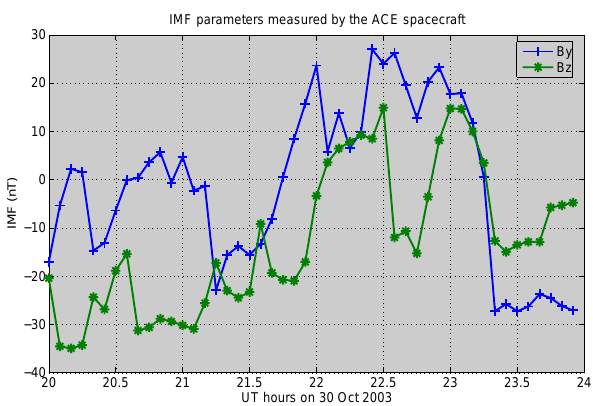
Fig. 10. IMF B y and B z variations vs. time every 5min between 20:00 and 24:00UT as measured by the ACE